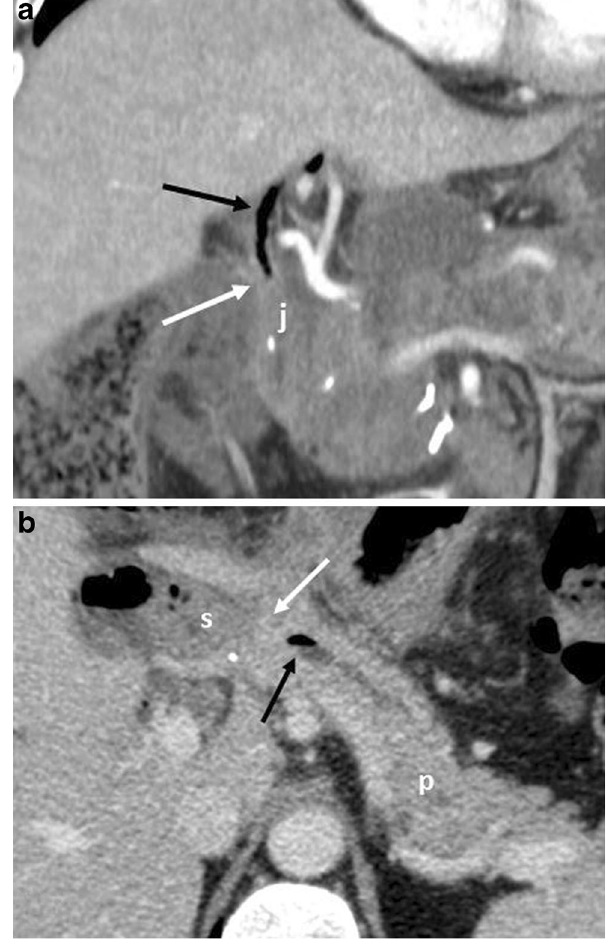
Fig. 8 Pneumobilia and pneumowirsung ( a , b ). a There is a fair amount of air in the main and in left bile ducts (black arrow). The hepaticojejunostomy (white arrow) and anastomotic jejunal loop (j) are visualised. b The pancreas (p), anastomotic jejunal loop (s) and pancreaticojejunostomy (white arrow) are visualised. The main pancreatic duct is mildly dilated with an air bubble within (black